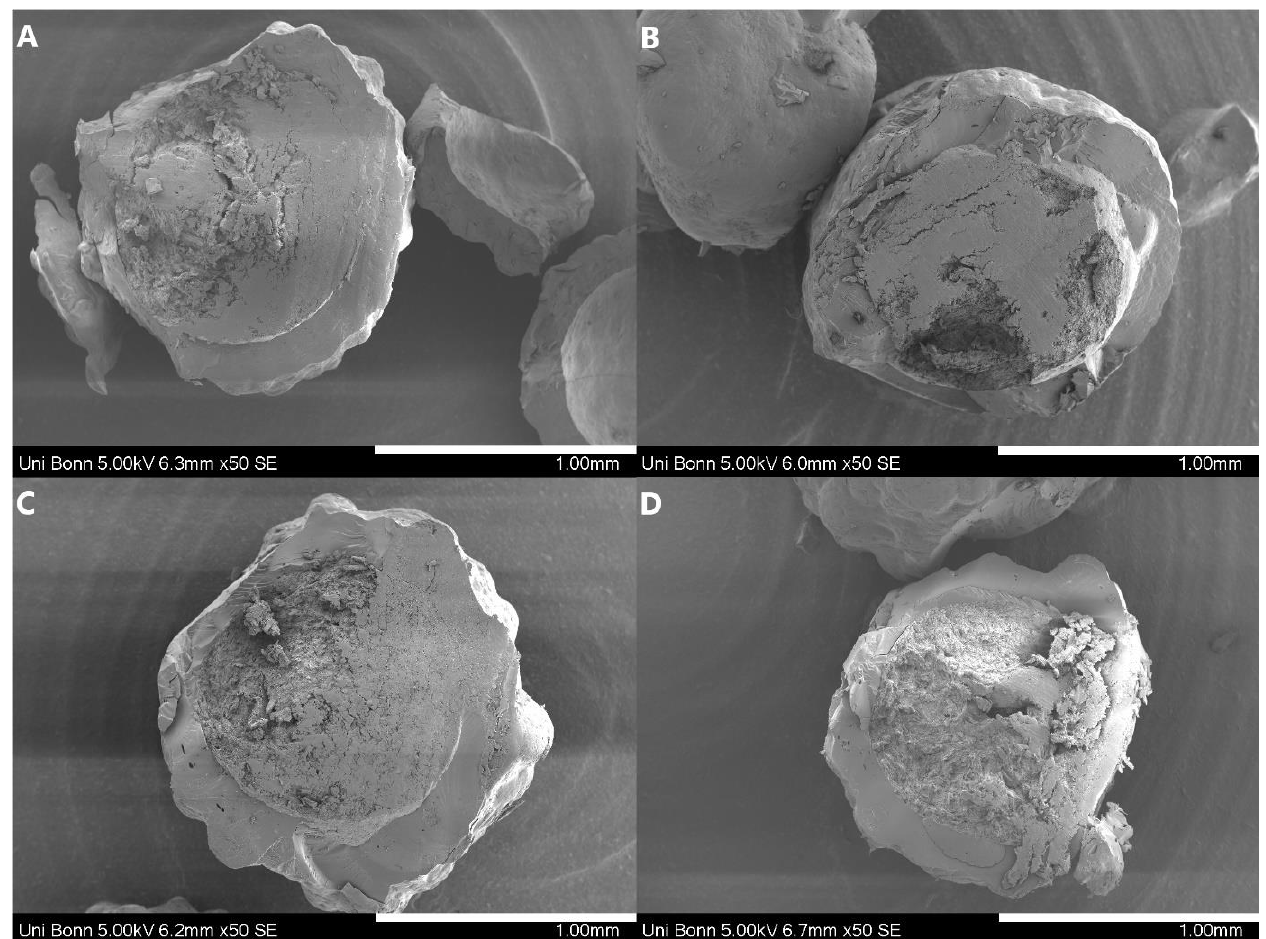
Figure 3. SEM-images of cross-sectional areas of the prepared pellets: (( A ) KCZ_HPMC-AS_PC; ( B ) KCZ_EL100-55_PC; ( C ) LRD_HPMC-AS_PC; ( D ) LRD_EL100-55_PC). All samples were sputtered with gold and observed with a Hitachi SU3500 at 5.0 kV in SE-mode and a 50-time magnification. The white scale bar represents 1 mm.